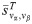
Best intra-subject variability estimate based on overall similarity.For each pair of intra-subject threshold noise να and slope noise νβ, the overall similarity (combined for threshold, slope, and lapse rate) averaged across Nsimulations = 1000 simulations (s¯να,νβT) is represented as a heat map. The dashed white iso-reliability contour is identical to Fig 3. The noise level pair on the contour with the highest overall similarity (s¯ν^α,ν^βT=0.764) is indicated with a black dot.